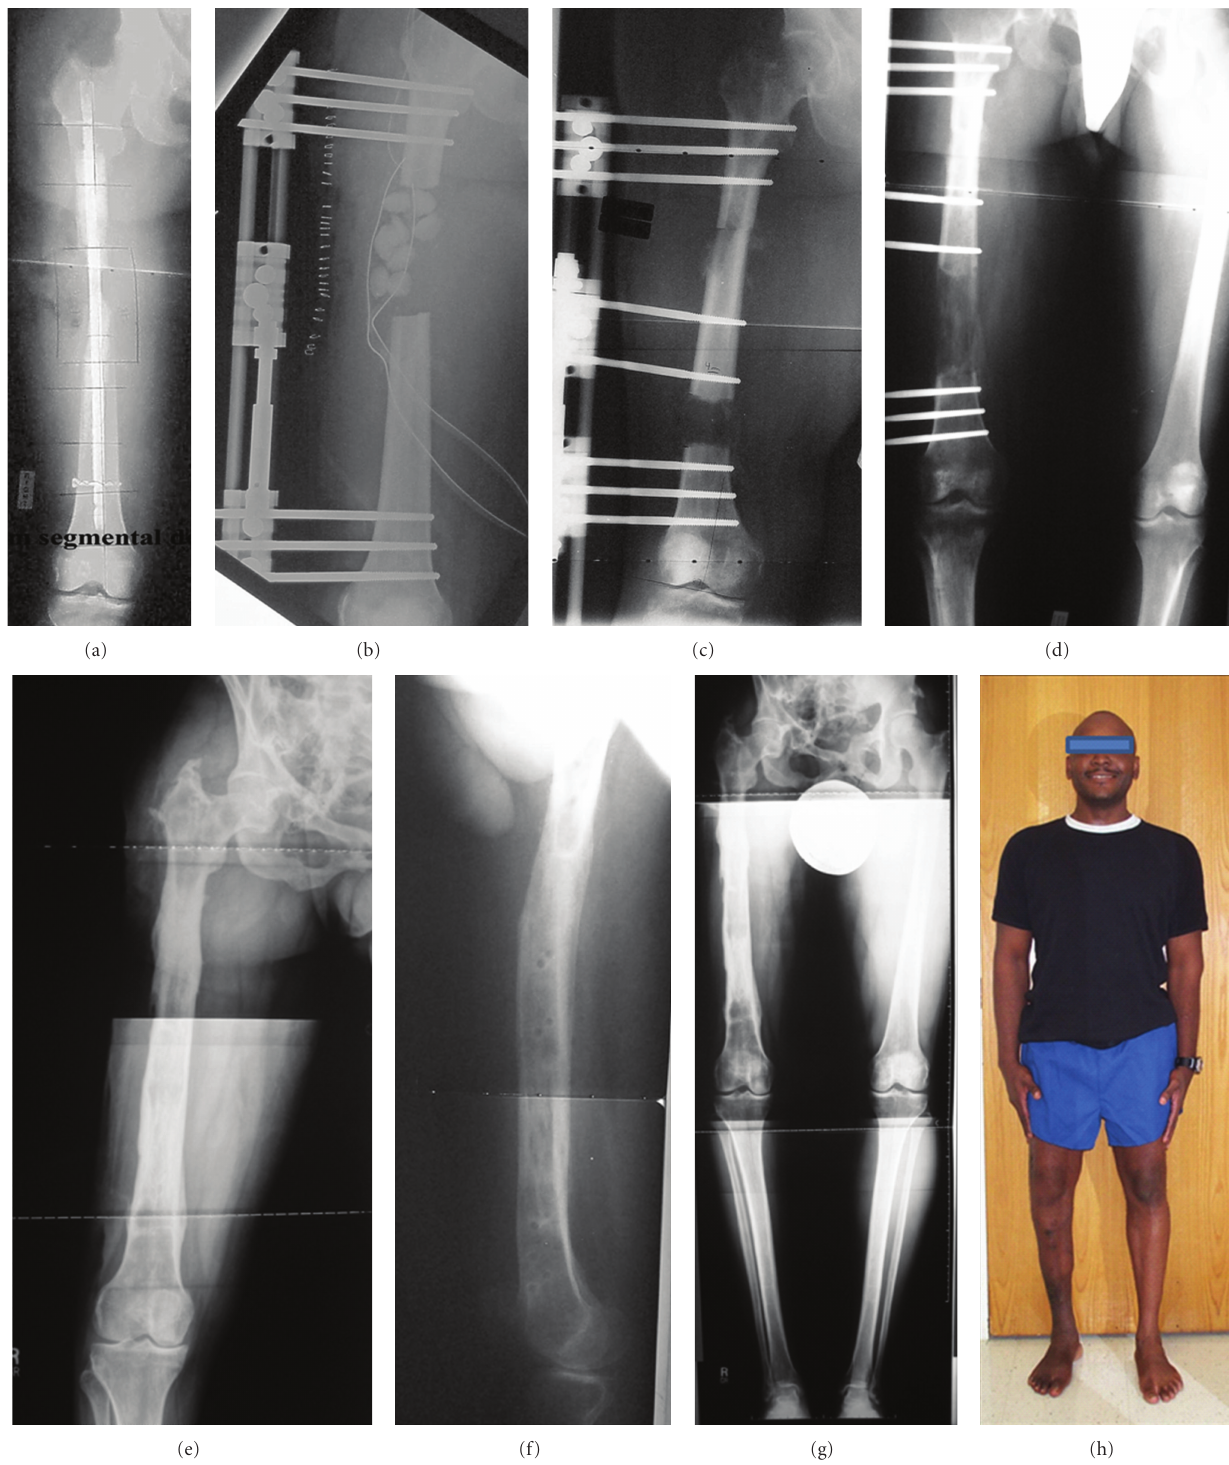
Figure 2: 28-year-old male with posttraumatic infected (vancomycin resistant enterococcus fecaelis) femur with 9cm bone loss. (a) Preoperative AP X-ray showing bone loss and intramedullary rod in place. (b) After stage 1 surgery to remove hardware, apply monolateral external fixator,and insert antibiotic coated cement beads. Gradual shortening ofthe defect wasdone.(c) After stage 2 surgery which involved distal femur osteotomy for lengthening and further shortening of the defect. Note the removal of antibiotic beads. (d) At end of distraction. Note 9cm distal femur lengthening and compression at the proximal docking site. (e)–(h) Follow-up one year after frame